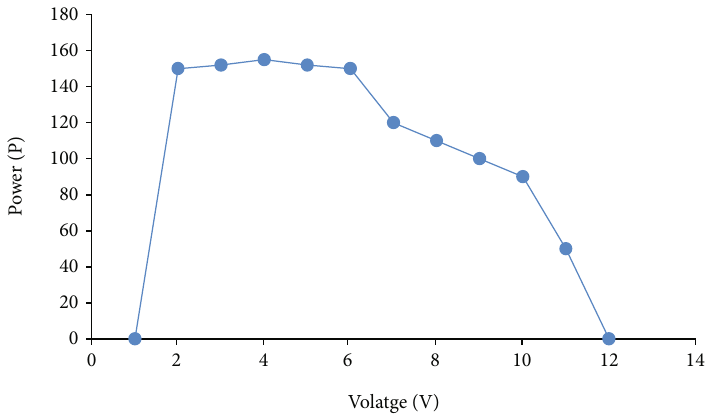
Figure 6: Floating PV on the P-V curve.